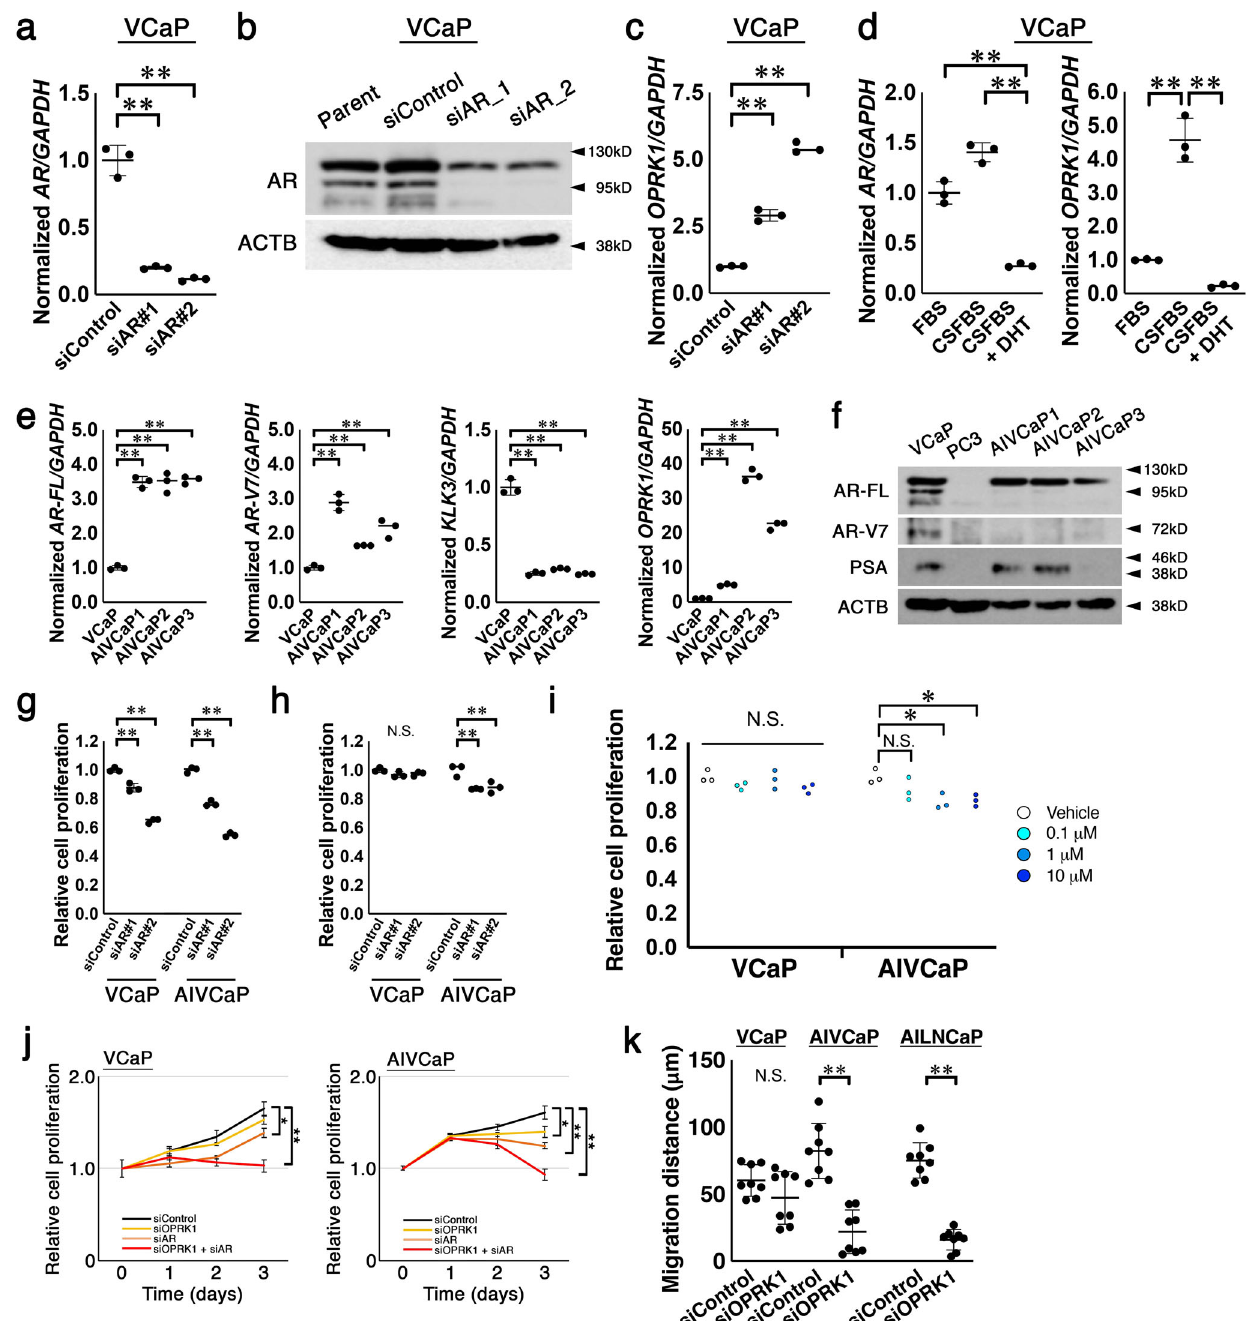
Fig. 5 AR suppression upregulates OPRK1, which underpins androgen-independent growth of androgen-independent derivatives of VCaP cells. a , b Expressions of AR in VCaP treated with siRNA for GFP (siControl) and AR (siAR#1 and siAR#2) assessed by quantitative RT-PCR ( a ) and western blot ( b ). ** P < 0.01, Normalized by GAPDH ( a ) and β -actin (ACTB, b ). c Expression of OPRK1 in VCaP treated with siRNA for GFP (siControl) and AR (siAR#1 and siAR#2) assessed by quantitative RT-PCR. ** P < 0.01, Normalized by GAPDH . d Expression of AR (left) and OPRK1 (right) in VCaP cultured in media supplemented with 10% FBS, charcoal-stripped FBS (CSFBS), and CSFBS plus 1 nM dihydrotestosterone (DHT) assessed by quantitative RT-PCR. ** P < 0.01, Normalized by GAPDH . e Summarized results of quantitative RT-PCR for full-length AR ( AR-FL ), AR variant 7 ( AR-V7 ), KLK3 , and OPRK1 normalized by GAPDH in indicated cells. ** P < 0.01. f Western blot of indicated proteins in VCaP, PC3, AIVCaP1, AIVCaP2, and AIVaP3. β -actin (ACTB) acted as loading control. g Summarized results of proliferation rates of VCaP and AIVCaP2 (AIVCaP) treated with siRNA for GFP (siControl) and AR (siAR#1 and siAR#2). h Summarized results of proliferation rates of VCaP and AIVCaP2 treated with siRNA for GFP (siControl) and OPRK1 (siOPRK1#1 and siOPRK1#2). i Summarized cell proliferation rates of VCaP and AIVCaP2 (AIVCaP) with regard to the concentration of supplemented nor-BNI, OPRK1 inhibitor. * P < 0.05. j Cell proliferation in VCaP (left) and AIVCaP2 (AIVCaP) treated with siRNA for GFP (siControl), AR (siAR) OPRK1 (siOPRK1), or siAR plus siOPRK1. * P < 0.05, ** P < 0.01. k Summarized results of migration (scratch) assay with greater distance indicating higher migration ability. VCaP, AIVCaP, and AILNCaP cells were treated with indicated siRNA and subject to the assay. ** P <